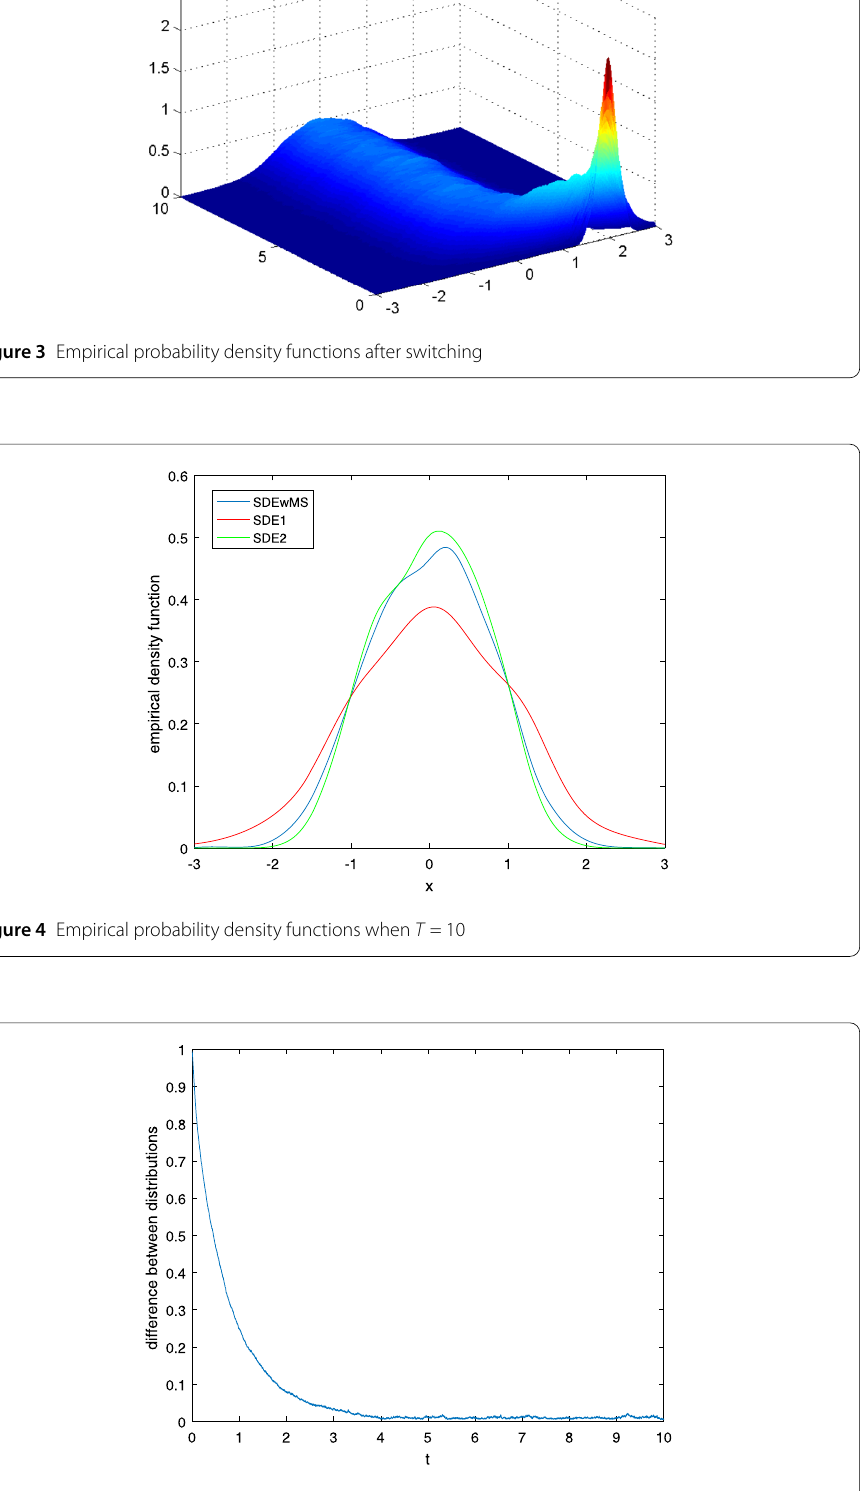
Figure 5 The difference between two adjacent empirical probability density functions after